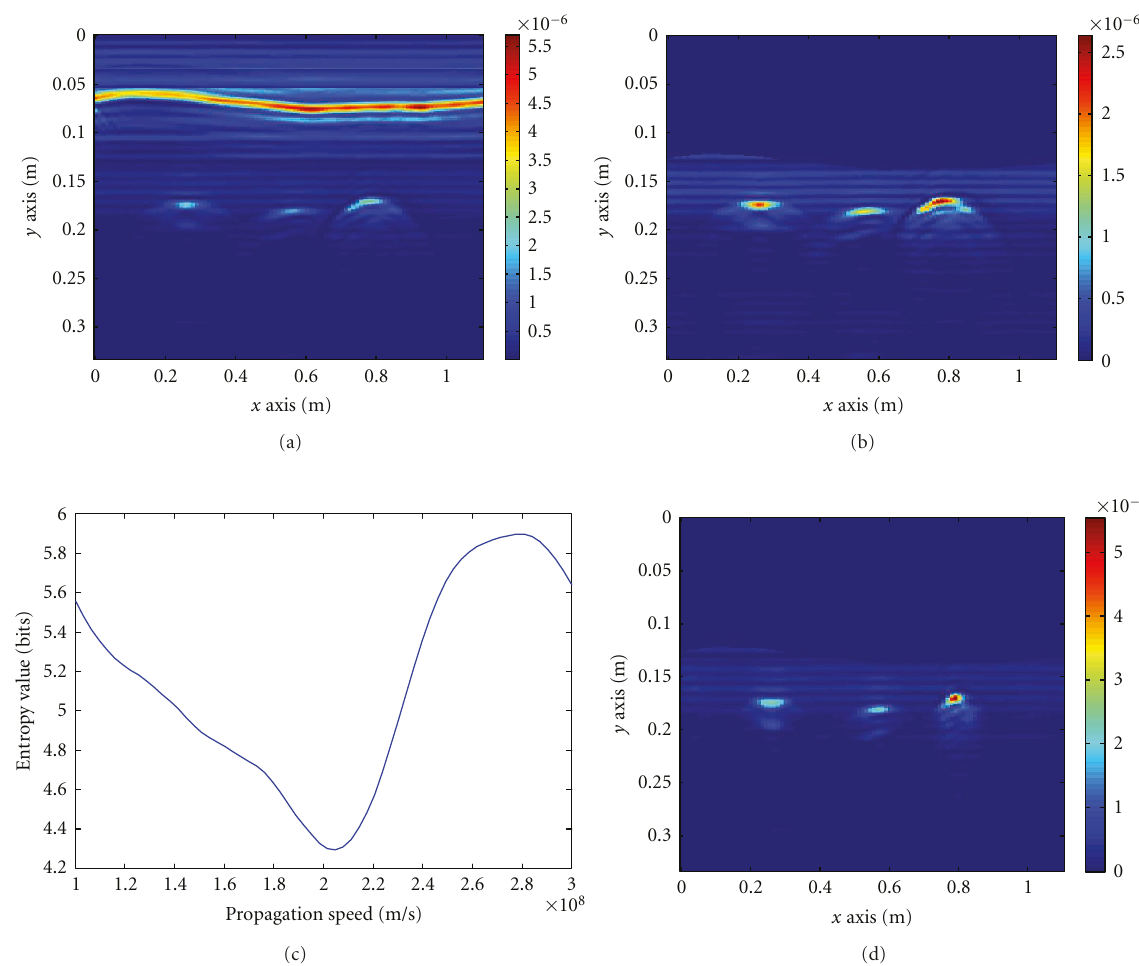
Figure 11: (a) Second experimental data set. (b) Denoised data set. (c) Entropy values for the interval [1 × 10 8 m/s, 3 × 10 8 m/s]. (d) Dataset reconstructed using v ∗ .